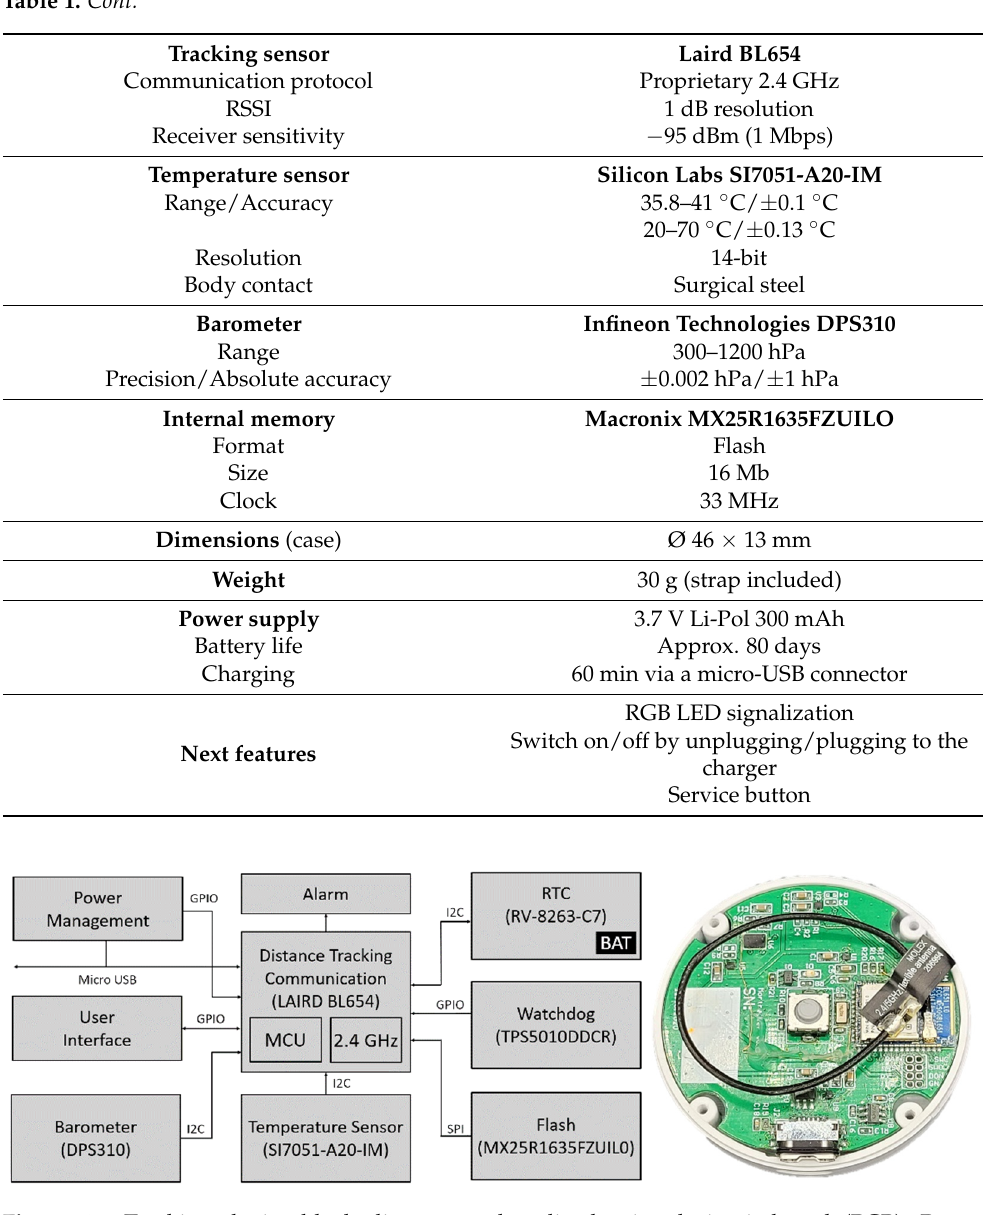
Figure 4. Tracking device block diagram and realized printed circuit board (PCB): Power manage- Tracking device block diagram and realized printed circuit board (PCB): ment—integrated circuit (IC) responsible for charging the battery and maintaining a stable supply of voltage for the microcontroller unit (MCU) and other circuit logic; Alarm—RGB LED signaliza- tion; RTC—time recorder; Watchdog—component for resetting the system in case of MCU error; Barometer—atmospheric pressure monitoring; Temperature sensor—wrist temperature monitor- ing; Flash—long-term non-volatile storage for the MCU; User Interface—buzzer and button to com- municate status, battery level, and syncing operation to the user; LAIRD BL654—main MCU used to control the connected components and direct operations of the device. Table 1. Tracker device parameters.